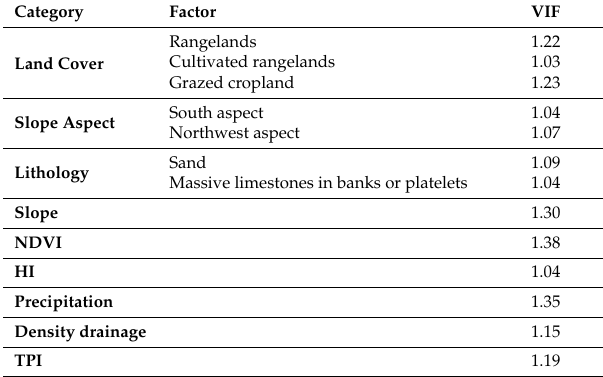
Table 2. The multicollinearity diagnosis index for 13 predicting factors. VIF: variance inflation